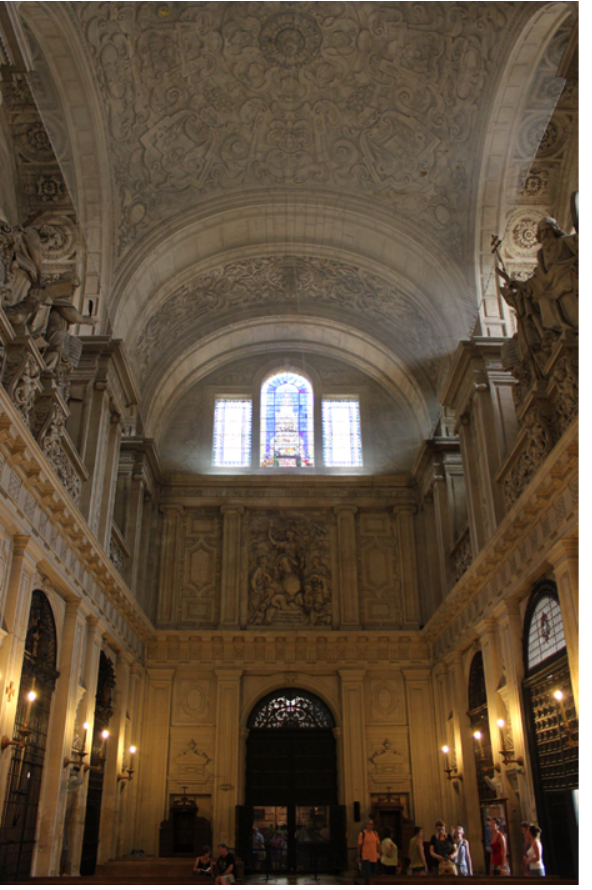
Figure 9: Interior of the Sagrario. The Epistle side of the nave. Image from https://www.flickr.com/photos/turis- mosevilla/5903714667/in/photolist-9ZG7gz-9ZJYaA- 9ZG6R8-9ZG6BK-9ZG6pT-9ZG6d2-9ZG624-9ZG5FV- 9ZJWAm-9ZG5ft-9ZG556 Photo by Turismo de Sevilla (Creative Commons